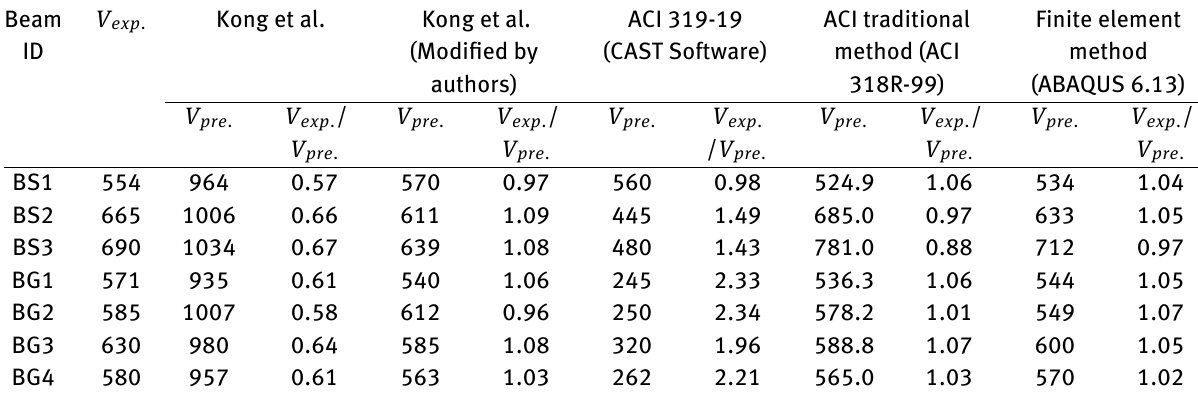
Table 15: Prediction of ultimate shear strength